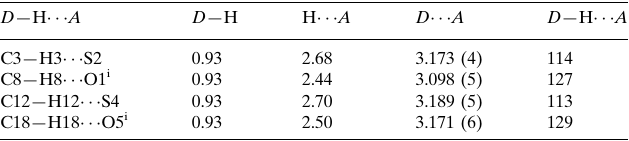
Hydrogen-bond geometry (A˚ , (cid:2)